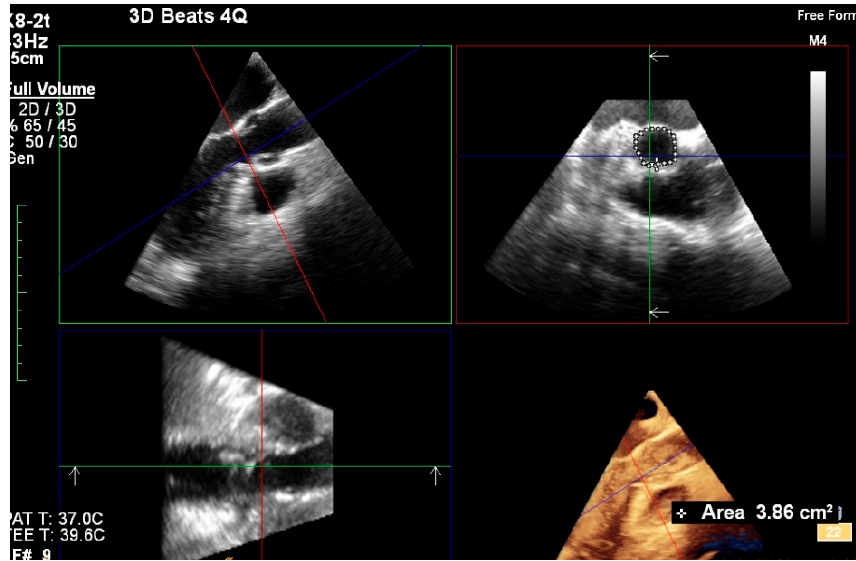
Figure 2. Assessment of aortic annular plane via 3D TEE imaging.